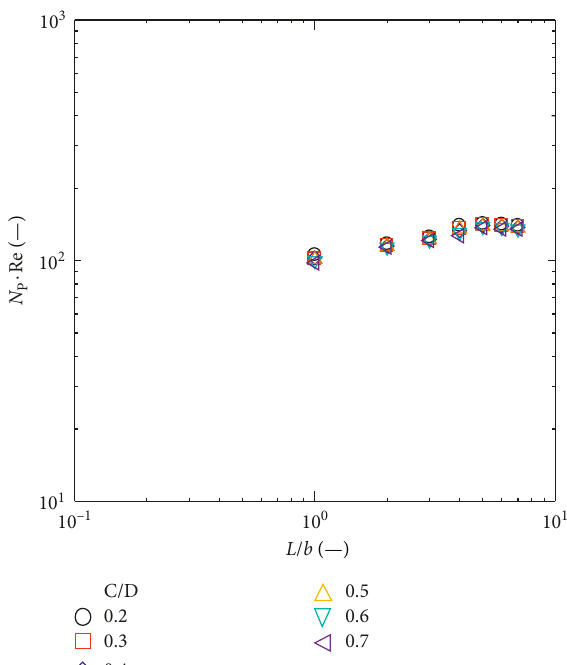
Figure 7: Effect of distance between the lower impeller and the off bottom on power consumption ( d / D � 0.43, b / d �